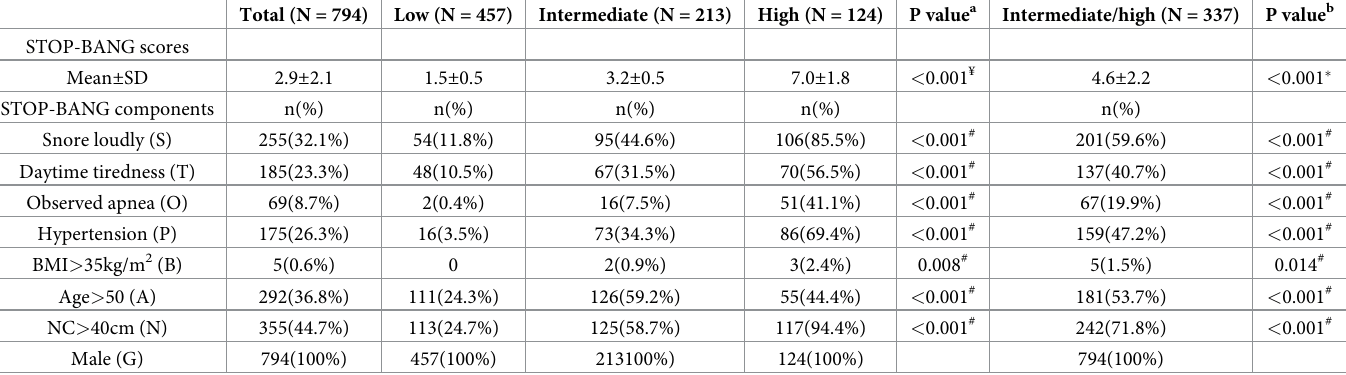
Table 2. Components of the STOP-BANG questionnaire grouped by OSA risk assessed by STOP-BANG